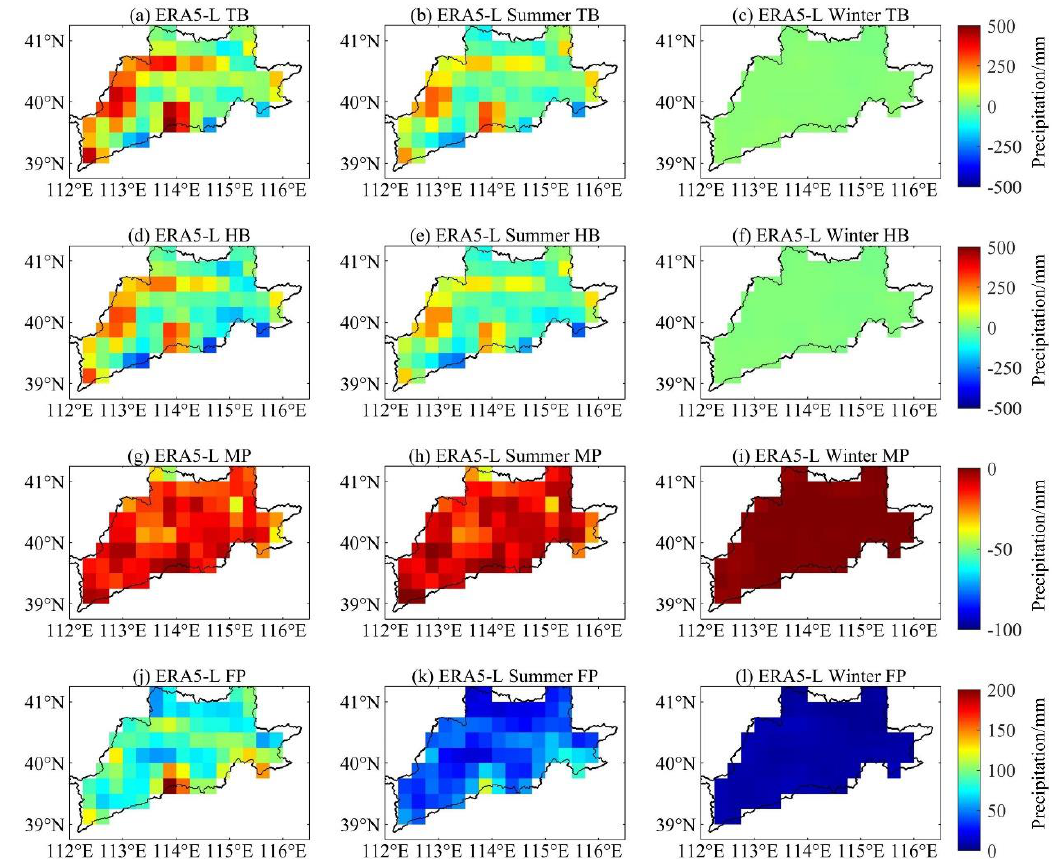
Figure 8. ( a – l ) TB , HB , MP , and FP of ERA5-Land reanalysis precipitation dataset.